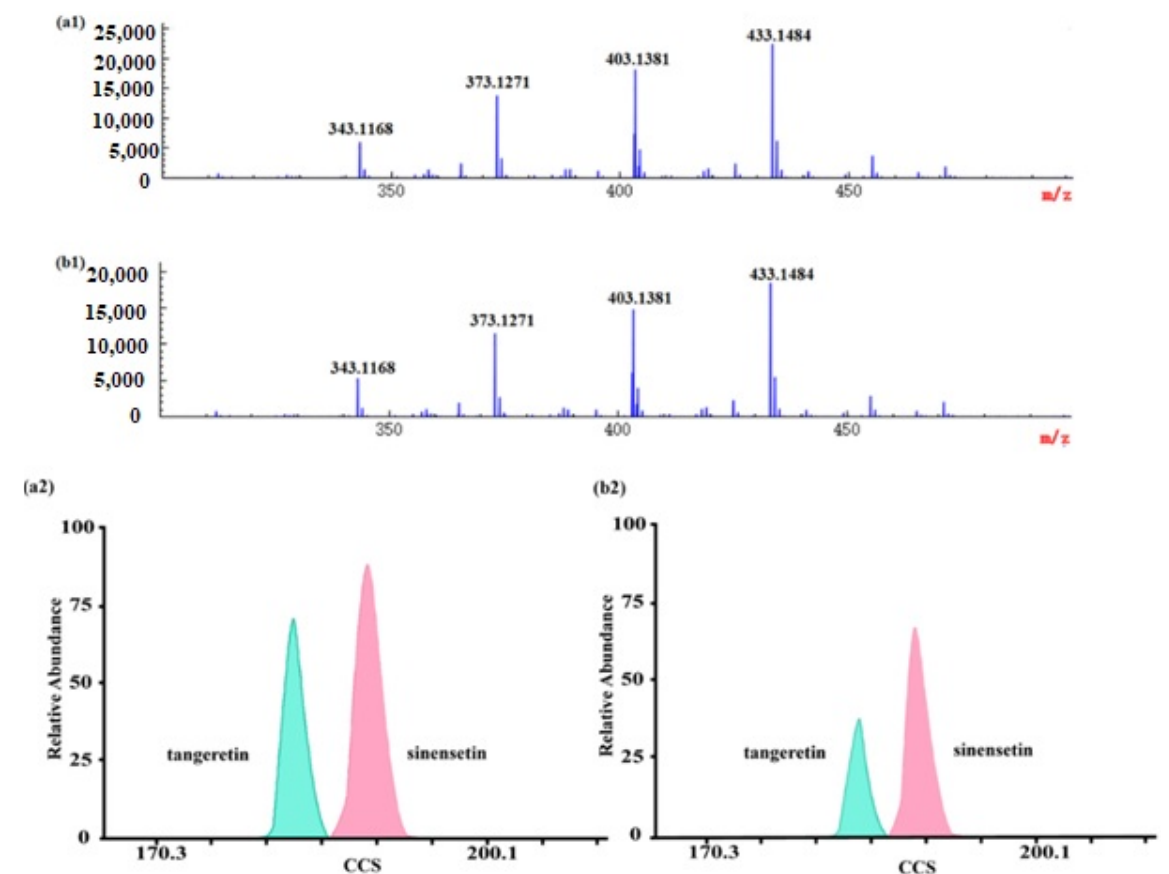
Figure 4. MS spectra and UMA spectra of polymethoxylated flavones in GCP and CP: ( a1 ) and ( b1 ) are MS spectra of polymethoxylated flavones in Guangchenpi and Chenpi, respectively; ( a2 ) and ( b2 ) are UMA spectra of tangeretin and sinensetin in Guangchenpi and Chenpi, respectively.